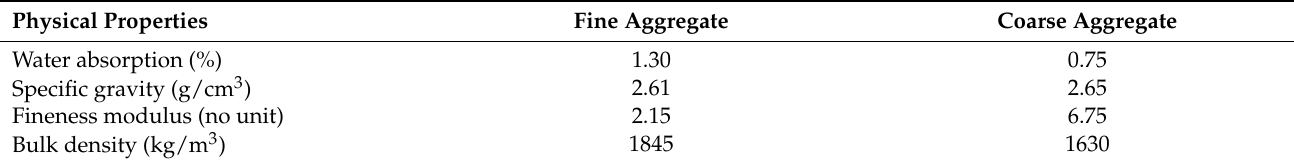
Table 3. Physical properties of